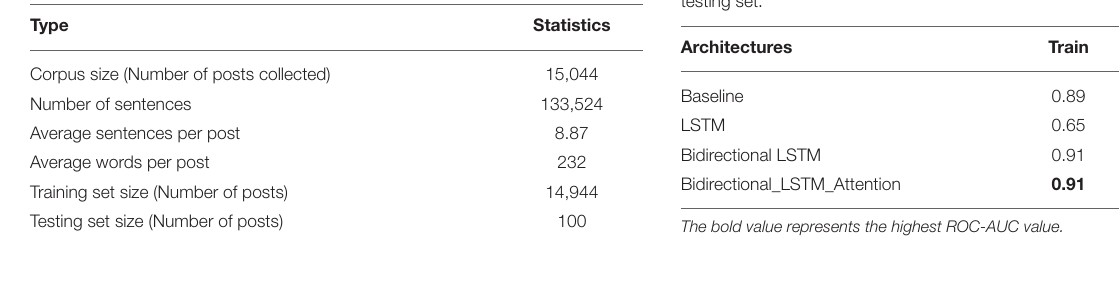
TABLE 2 | The statistical summary of the training and testing set.